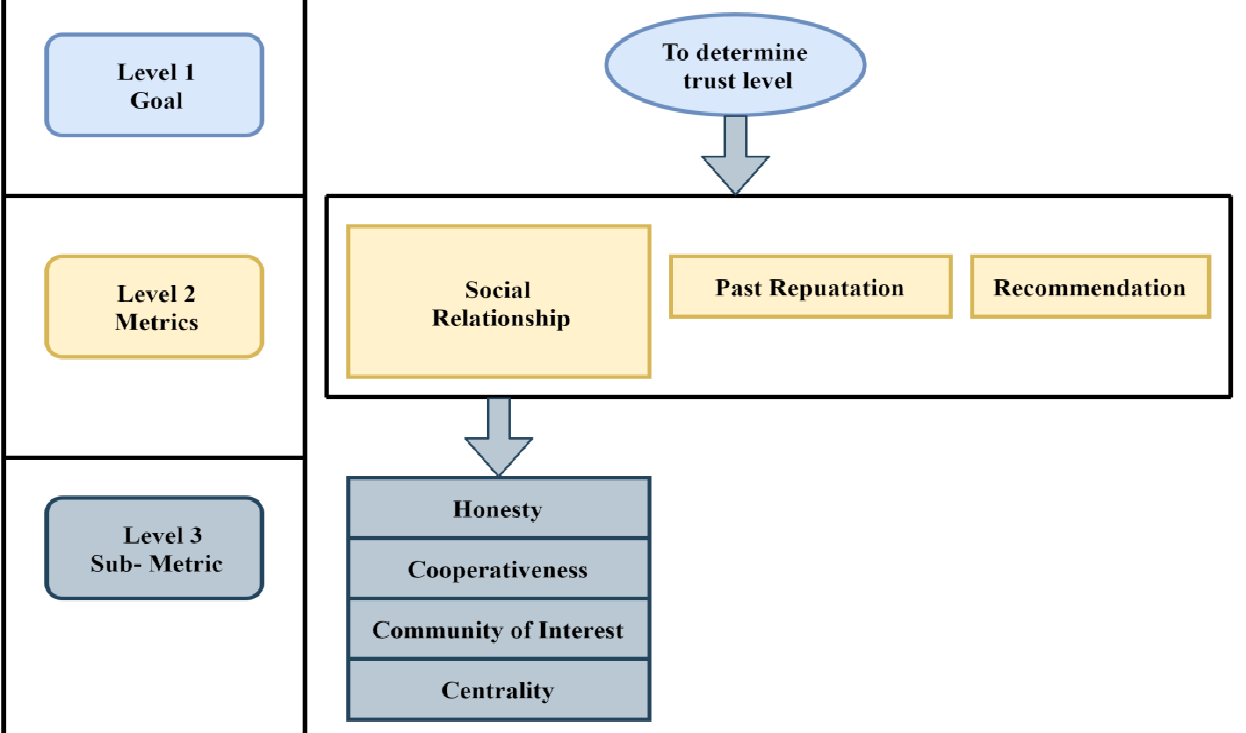
Figure 4. Trust-based Computation Hierarchy Model (SP to SR) using fuzzy-AHP.